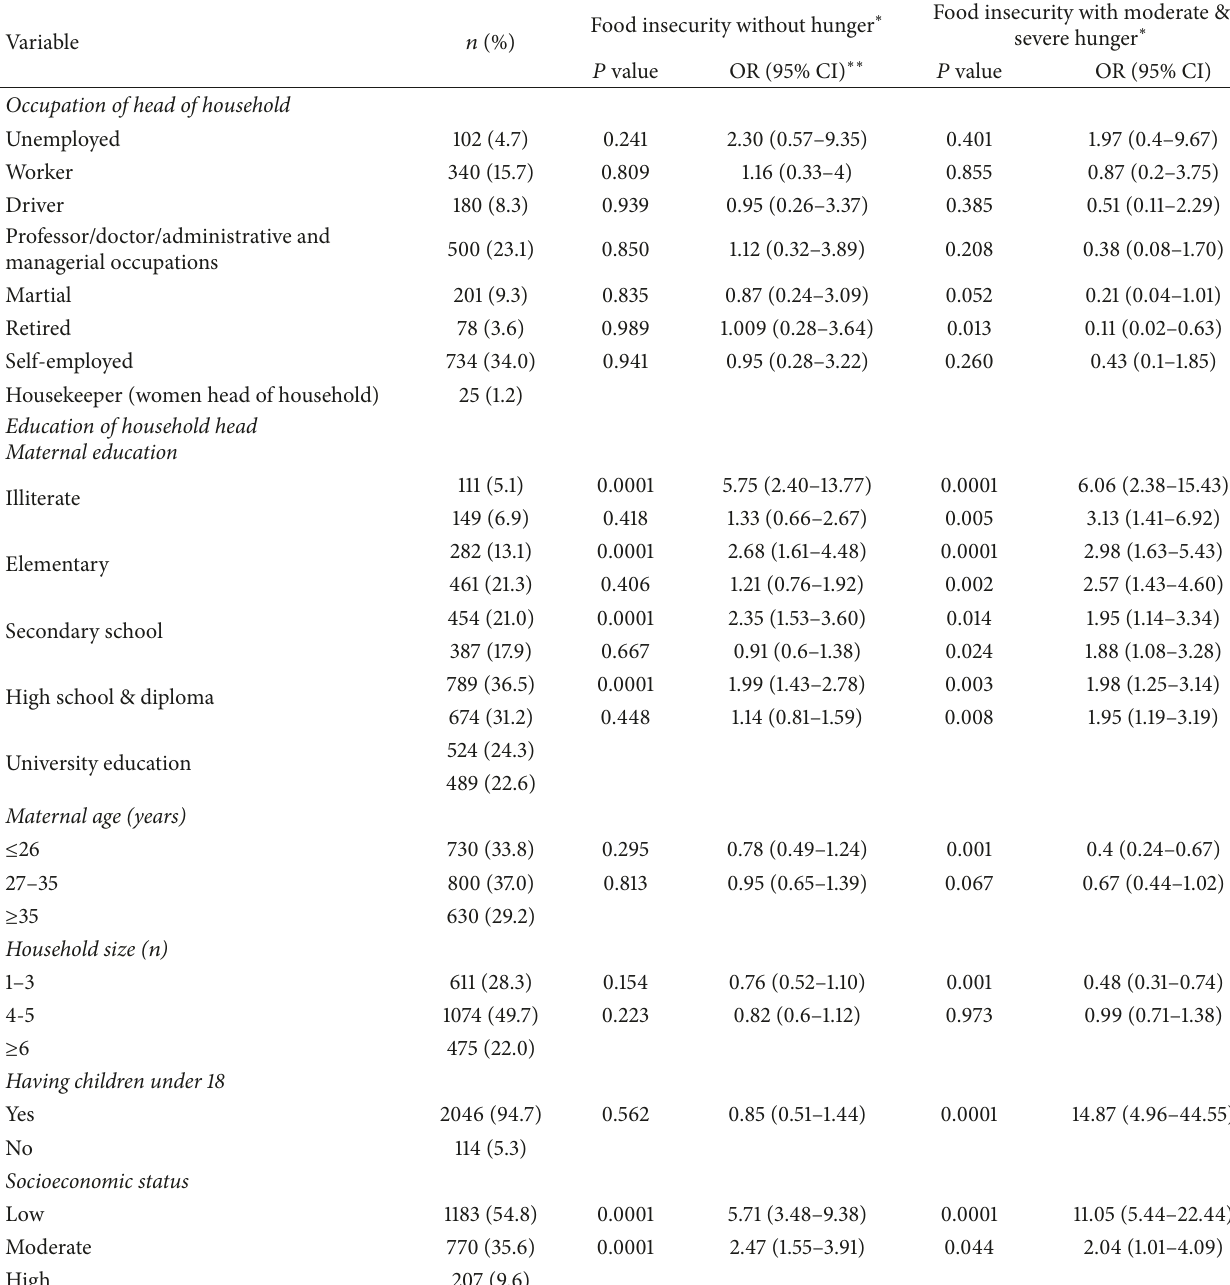
Table 2: Logistic regression model, socioeconomic and demographic factors affecting household food insecurity in households studied ( 𝑛 = 2160